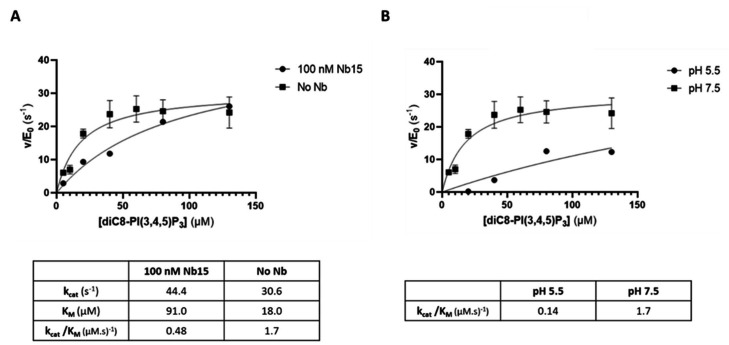
The 5‐phosphatase activity of Synj1528‐873 is affected by Nb15 and acidic pH.(A) Michaelis‐Menten curves obtained by using the Malachite green assay with 2.5 nM of human Synj1528‐873 and various concentrations of diC8‐PI(3,4,5)P3 in absence or presence of 100 nM Nb15. (B) Michaelis‐Menten curves obtained by using the Malachite green assay with 2.5 nM of human Synj1528‐873 and various concentration of diC8‐PI(3,4,5)P3 in assay buffer containing 25 mM HEPES at pH 7.5 or in assay buffer containing 25 mM sodium citrate at pH 5.5.